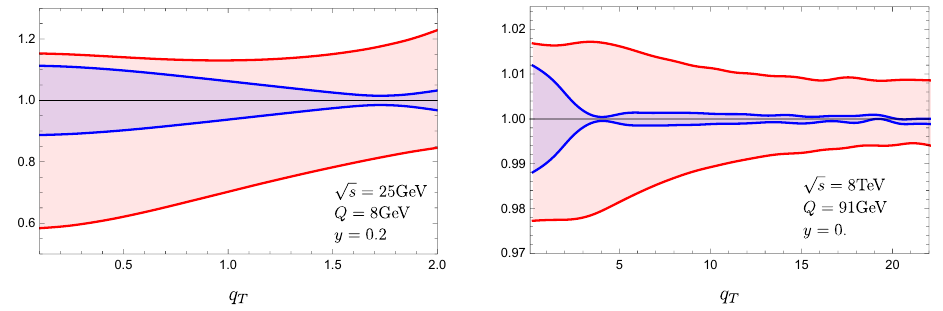
Figure 9 . The size of the uncertainty bands for predicted cross-section due to collinear PDF uncertainty (red band) and due to experimental uncertainties (blue band), at low and high-energies. Both bands are weighted to the prediction obtained with NNPDF31 collinear distribution.